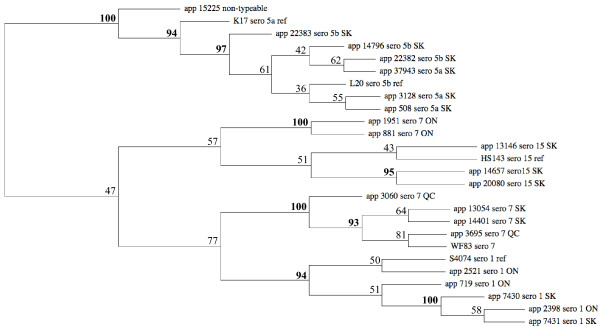
Hierarchical clustering of field isolates of A. pleuropneumoniae based on M-CGH data excluding phage and transposase genes.